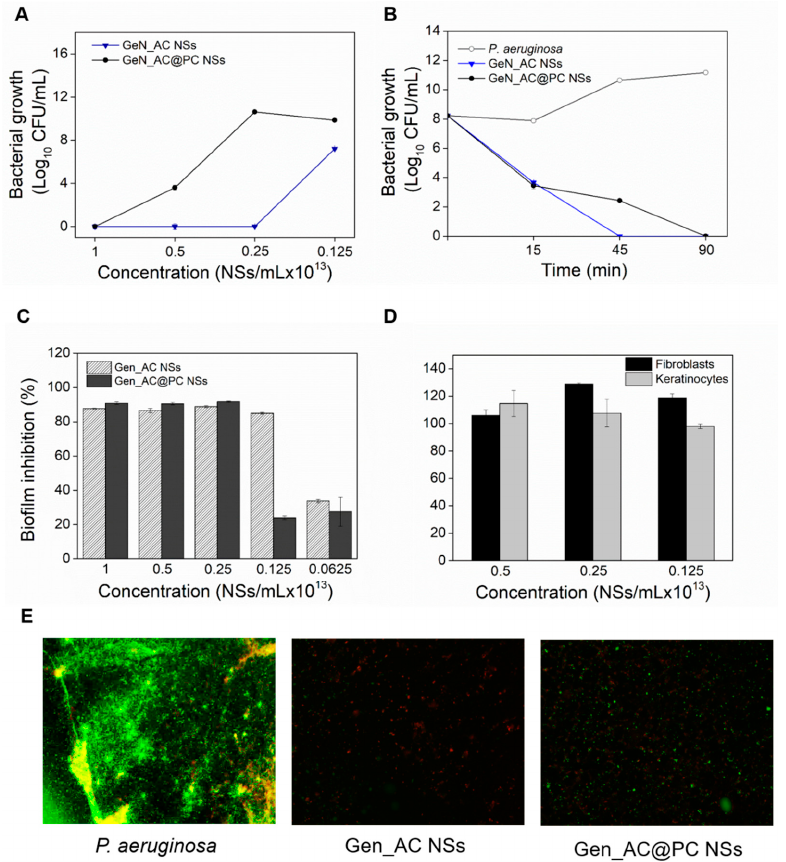
Figure 7. Protein corona effect on GeN_AC NSs functionalities. ( A ) P. aeruginosa growth after 24 h incubation with different concentrations of protein corona and non-protein corona GeN_AC NSs; ( B ) Time–kill curves of GeN_AC NSs before and after incubation in protein-rich conditions; Inhibi- tion of P. aeruginosa biofilms by GeN_AC NSs and GeN_AC@PC NSs assessed with ( C ) crystal violet and ( E ) live/dead cells viability kit. The green (live cells) and red (dead cells) fluorescence images are overlaid. Scale bar corresponds to 100 μ m; ( D ) Relative viability of HaCaT and BJ-5ta cell lines after 24 h of exposure to varying concentrations (1, 0.5, and 0.25 × 10 13 NSs mL − 1 ) of GeN_AC@PC NSs.